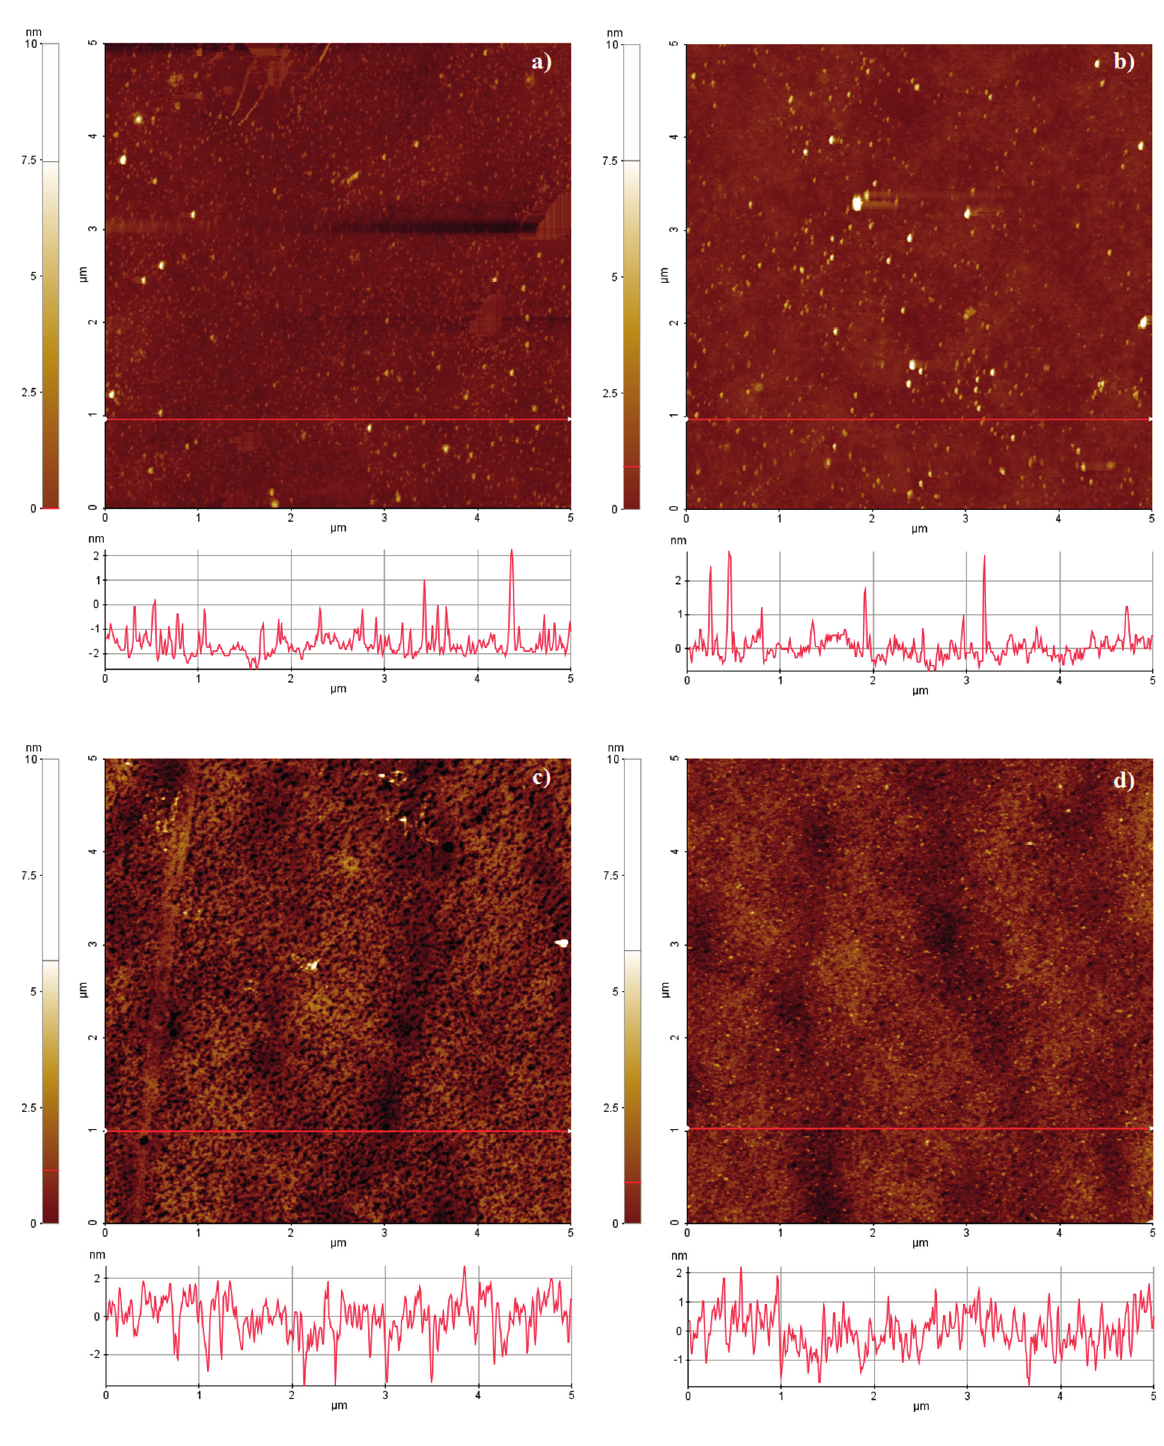
Figure 3. AFM morphologies: ( a ) glass; ( b ) Pd_glass; ( c ) polycarbonate; ( d ) Pd_polycarbonate. The selected images are representative of the samples